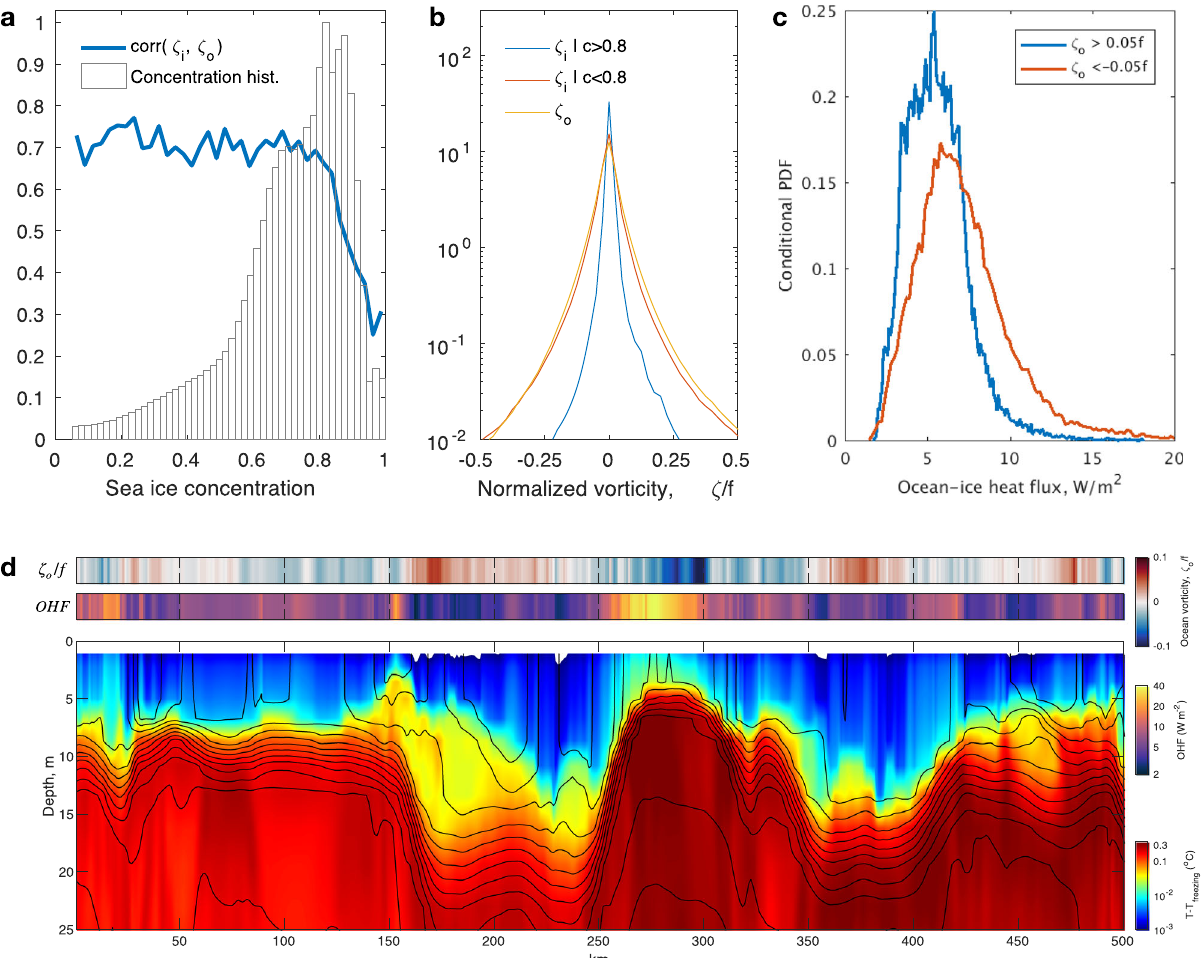
Fig. 2 The in fl uence of mechanical and thermodynamic ocean processes on sea ice during characteristic summer Arctic conditions, with quantities calculated based on the model state shown in Fig. 1. a Normalized histogram of sea ice concentrations (shown in bars) and the correlation coef fi cient between the sea ice and upper-ocean vorticity, ζ i and ζ 0 , as a function of sea ice concentration (blue curve). An abrupt transition to enhanced vorticity correlations occurs for concentrations below ~80%. b Histograms of ocean vorticity (yellow) and sea ice vorticity for concentrations above and below 80% (blue and red curves, respectively). c Probability density function of ocean-ice heat fl uxes in anticyclones (red) and cyclones (blue). All plotted distributions are derived from the summertime model snapshot shown in Fig. 1 and while the critical concentration stays the same, the histograms of sea ice concentration and the distribution of ocean-ice heat fl uxes change substantially depending on the season. d The deviation of ocean temperature from freezing along an example transect (taken within the square box region outlined in Fig. 1c) that includes a strong anticyclonic eddy located between 250 km and 350 km. The two horizontal sub-panels show the upper-ocean vorticity (at 20 m depth) normalized by the Coriolis parameter f (top) and the ocean-ice heat fl uxes (OHF, middle), along the same